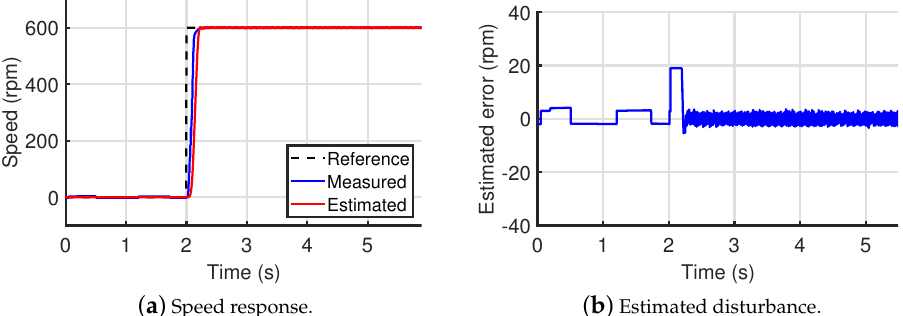
Figure 18. Experimental results of the proposed observer at 600 rpm.